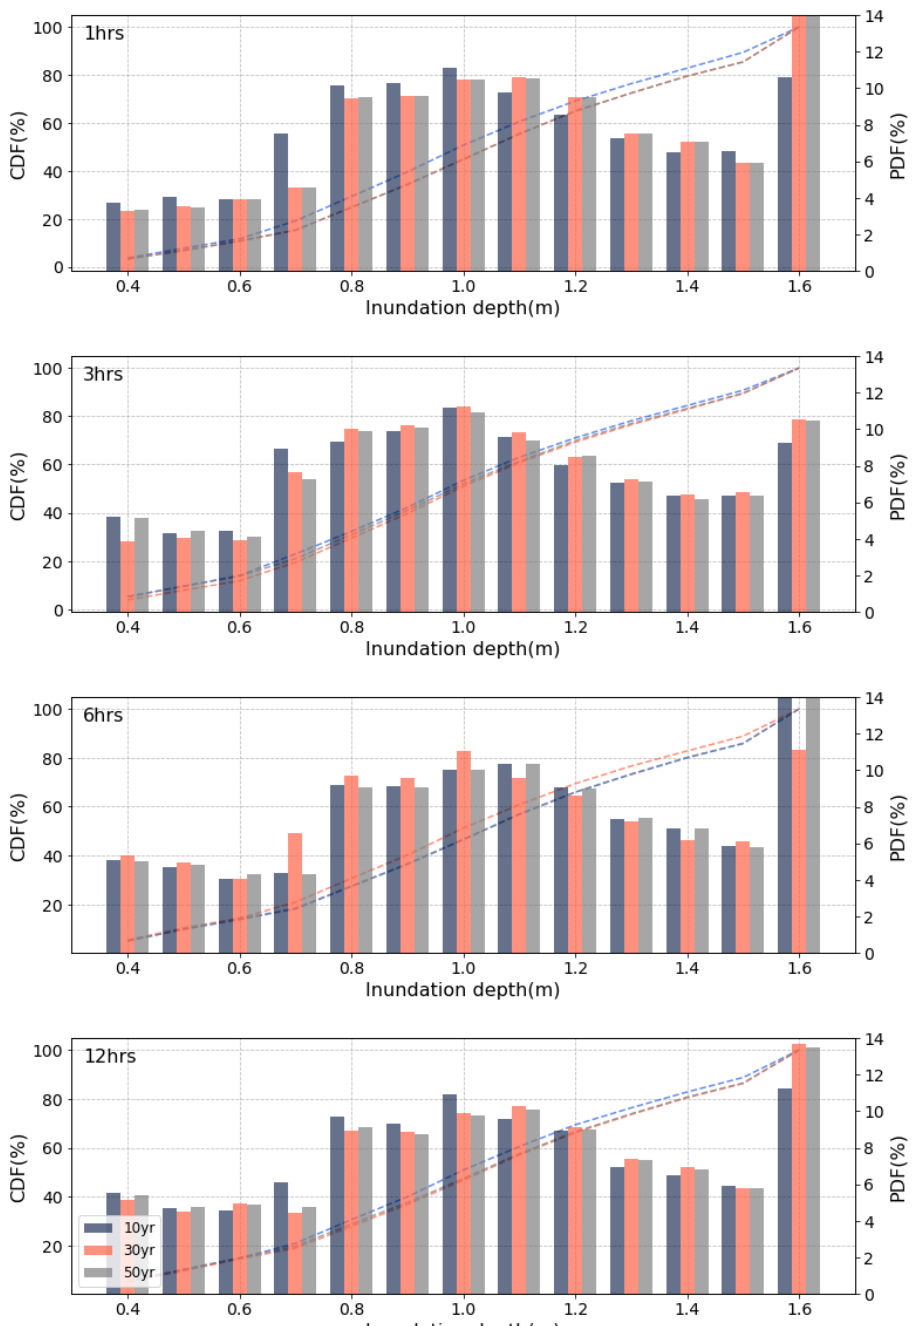
Figure 8. PDF and CDF of simulated inundation depth for target period III (2070 – 2100).